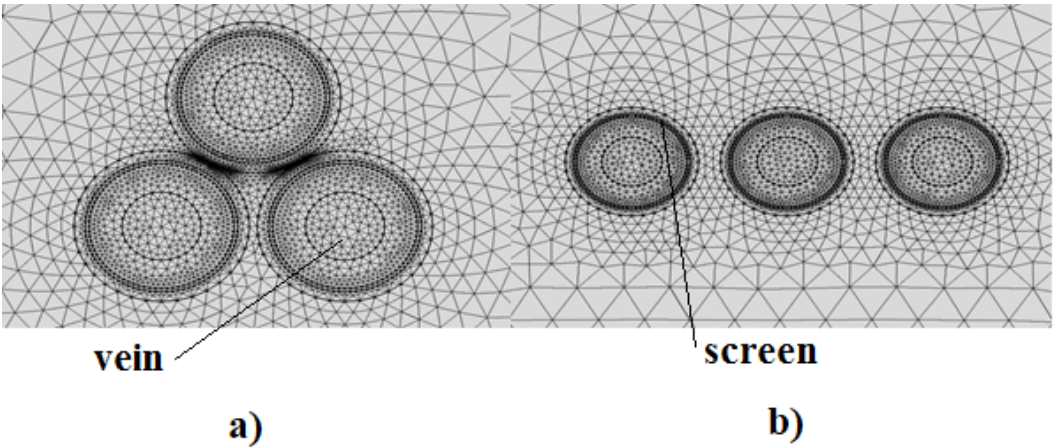
Figure 1. View of the model fragment with the applied mesh for a triangular system ( a ) and a planar system ( b